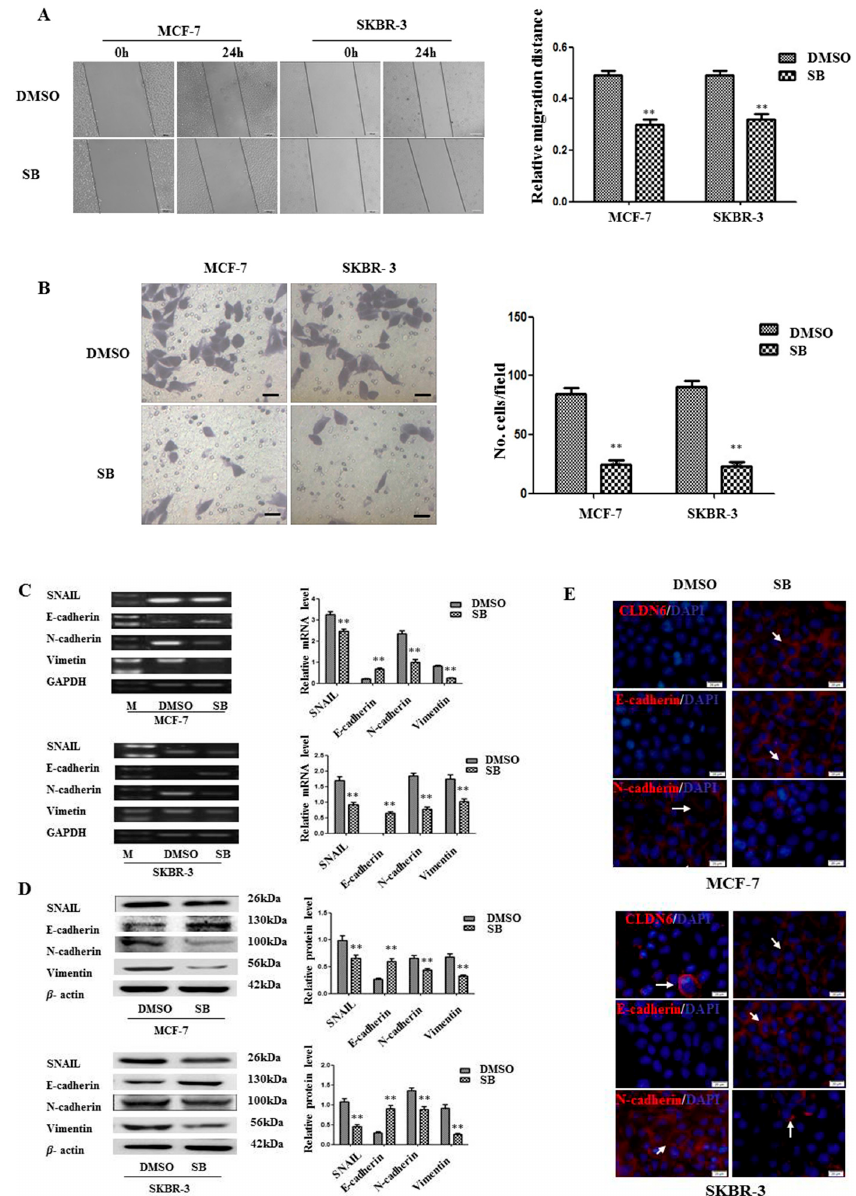
Figure 3. DNMT1-regulated CLDN6 expression inhibited tumor cell migration and invasion by blocking epithelial to mesenchymal transition (EMT). ( A ) Representative light microscope images of wound-healing assays for MCF-7 and SKBR-3 cells after treatment with or without SB431542 to evaluate their migration rate into the cell-free area (bar, 200 µm). ( B ) Matrigel invasion assay. Cells that invaded through the Matrigel were stained with Giemsa and counted. All results are presented as the average of cells counted in 10 fields per condition (bar, 50 µm). ( C ) RT-PCR; and ( D ) Western blotting analysis was used to determine the expression of EMT-related genes (SNAIL, E-cadherin, N-cadherin, and vimentin) in MCF-7 and SKBR-3 cells. Results of densitometric analysis of relative expression levels after normalization to loading control GAPDH or β -actin are presented. ( E ) Immunofluorescence analysis of the expression levels of EMT markers in MCF-7 and SKBR-3 cells. Representative immunofluorescence images (200×) generated using anti-E-cadherin, anti-N-cadherin, and CLDN6 primary and FITC-conjugated secondary antibodies in the breast cancer cells. Blue, cell nuclei were stained with 4, 6-diamidino-2-phenylindole. Localization of E-cadherin, N-cadherin, and CLDN6 (red) at the cell–cell junctions is indicated by white arrows (bar, 20 µm). ** p < 0.01. Bars represent mean ± SE ( n = 3).